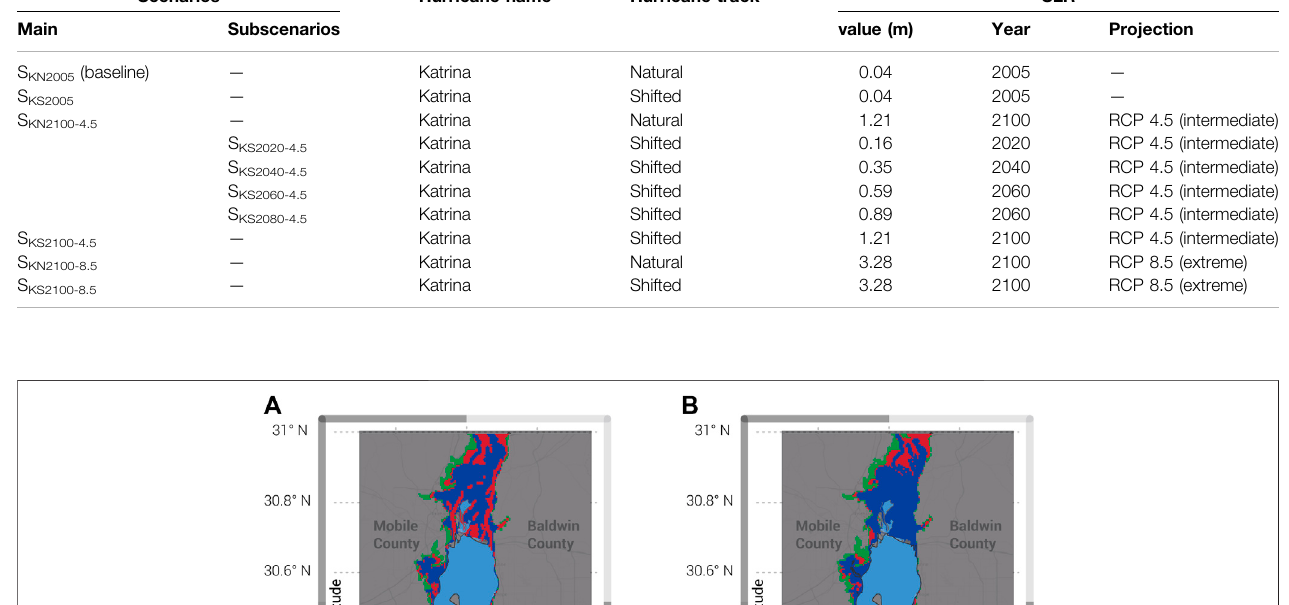
TABLE 1 | List of six hurricane scenarios considered for this study. Scenarios